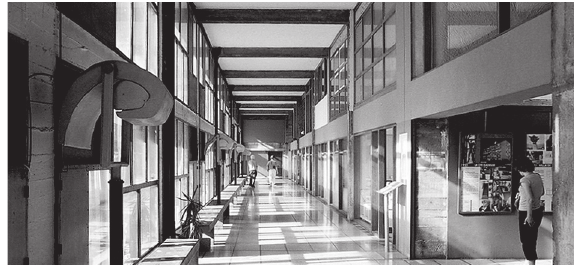
fig. 5. The gallery on the seventh